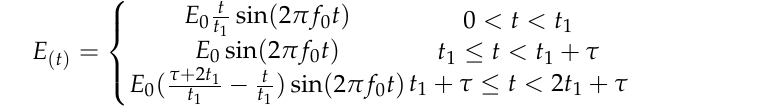
where the center carrier frequency f 0 is 1.5 GHz, pulse width τ = 80, and t 1 = 10 ns is its rising and falling time. Figure 5 shows the time and frequency domain waves. rising and falling time. Figure 5 shows the time and frequency domain waves.